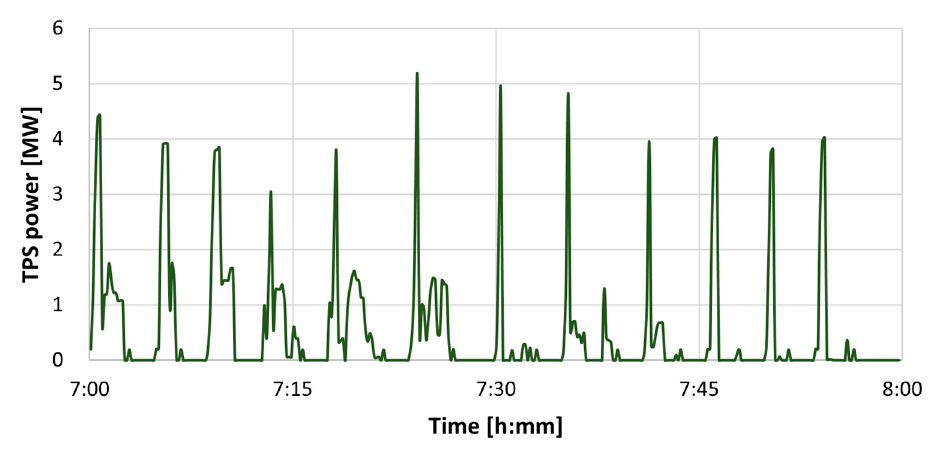
Figure 16. Power absorbed by the traction power substation between 7 a.m. and 8 a.m.